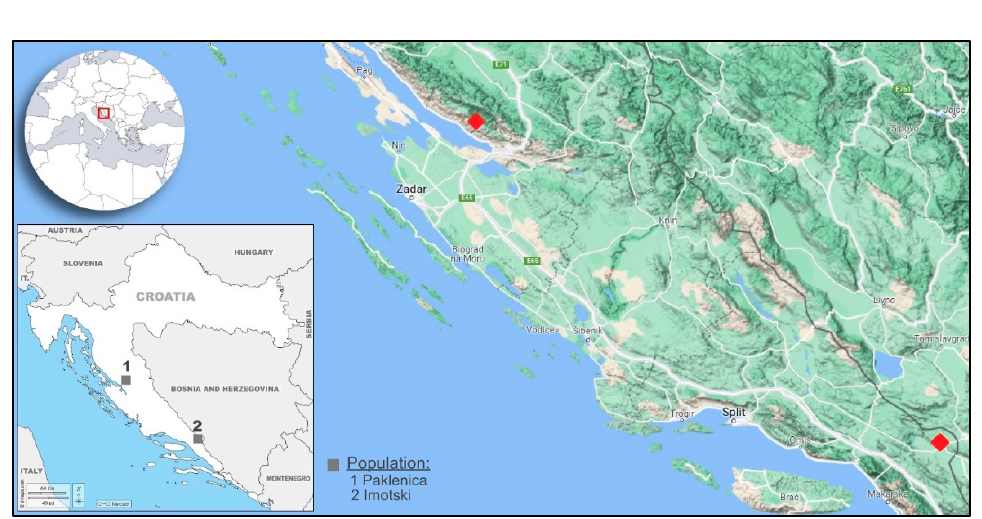
Figure 6. Two natural populations of V. sylvestris individuals analyzed in Croatia.